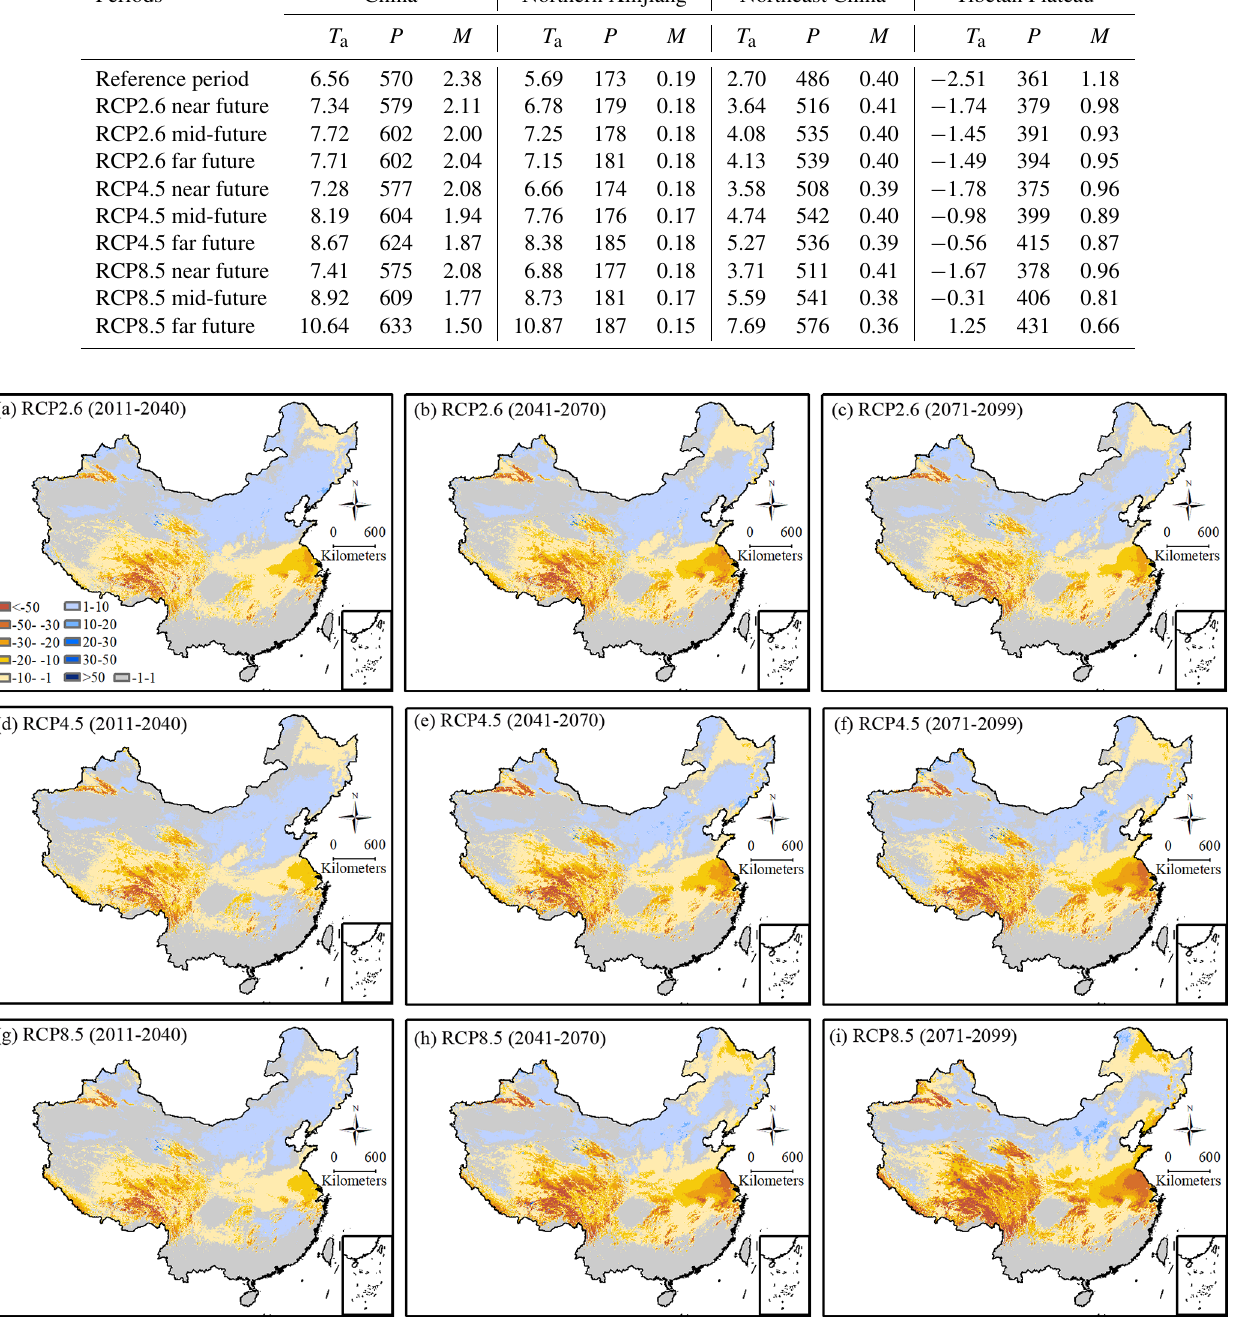
Figure 13. Spatial distributions of differences (millimeters) between the projected mean annual snowmelt and the reference period (1981– 2010) for the near future (2011–2040), mid-future (2041–2070) and far future (2071–2099) under RCP2.6, RCP4.5 and RCP8.5 in